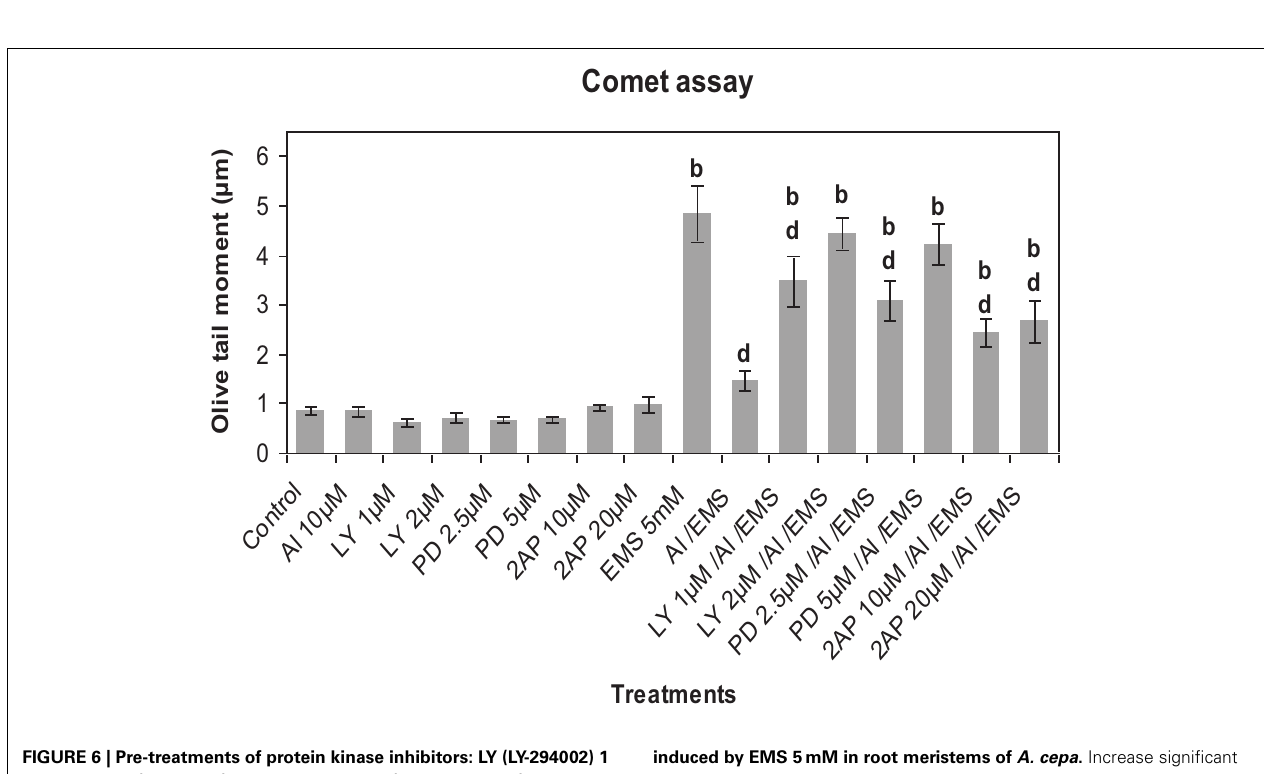
root tissue of A. cepa . Increase significant compared to control at p ≤ 0 . 01 (b); decrease significant compared to Al 3 + 800 μ M at p ≤ 0 . 05 (c) or 0.01 (d).